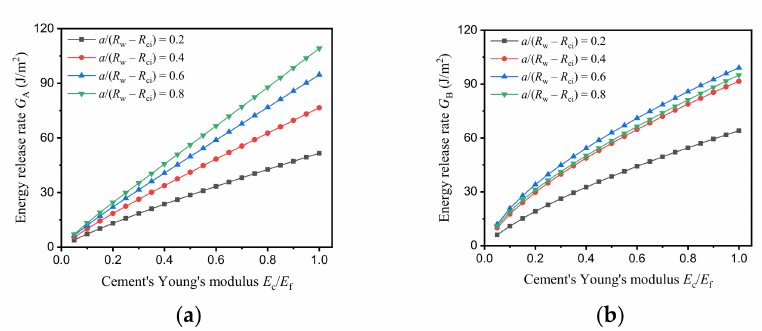
Figure 8. Energy release rate of a radial crack in cement as a function of the cement’s Young’s modulus: ( a ) crack tip A; ( b ) crack tip B.